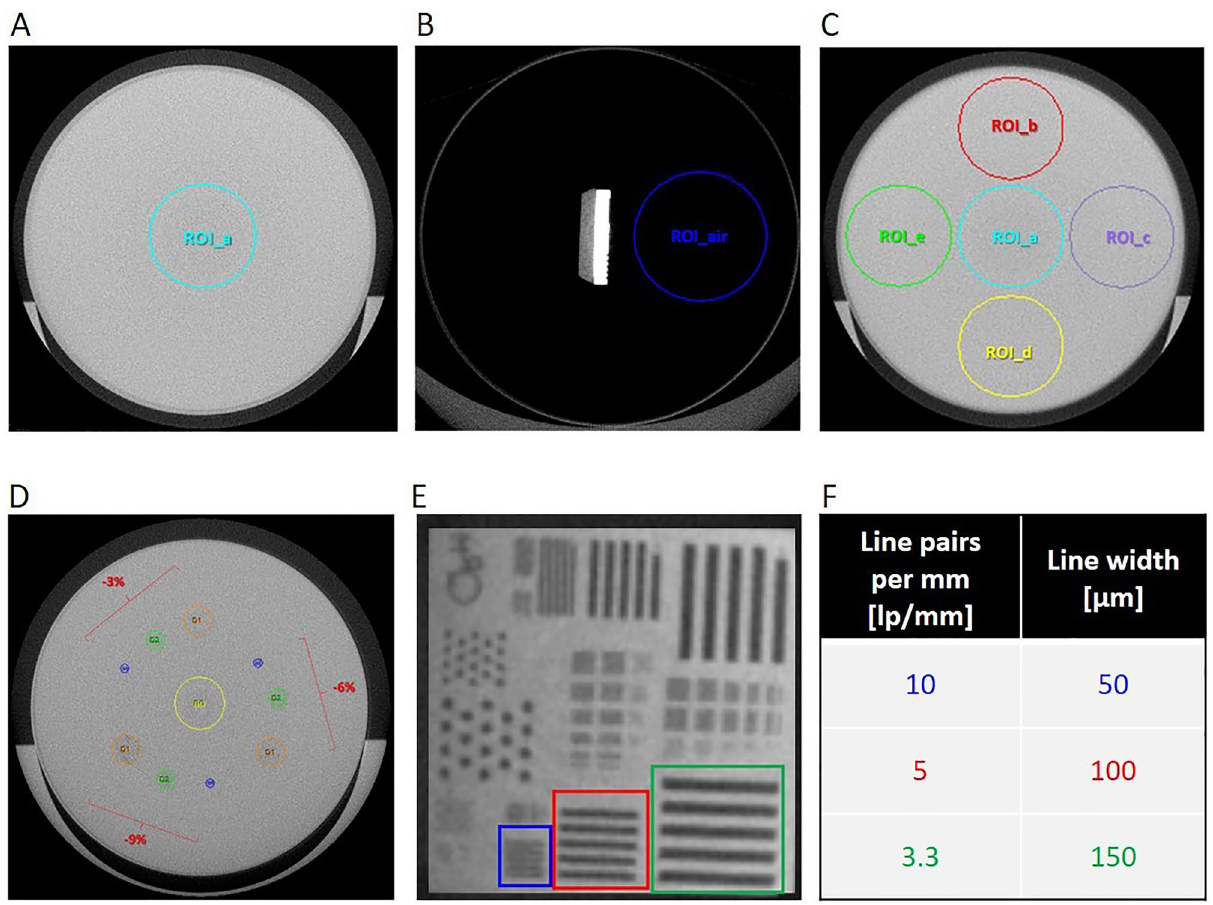
Figure 1. Axial views of micro-CT phantoms and segmentation maps used for the corresponding QC tests. ( A ) Water phantom with the ROI used to perform noise test and water value evaluation, within five contiguous slices. ( B ) Bar Pattern phantom filled with air with the ROI used to monitor air value, within five contiguous slices. ( C ) Water phantom with the ROIs used for the uniformity test, within five contiguous slices: one central (ROI_a) and four peripheral ROIs (ROI_b, ROI_c, ROI_d, ROI_e). ( D ) Low Contrast V2 phantom: the cylindric inserts with different low contrast levels (− 9, − 6 and − 3%) are identified by means of proportional ROIs, orange for 3 mm diameter, green for 2 mm diameter and blue for 1 mm diameter. The central yellow ROI is used to detect the background value. ( E ) The 5 × 5 mm 2 chip of the Bar Pattern phantom: the patterns used for the spatial resolution test are indicated in blue (10 lp/mm), red (5 lp/mm) and green (3.3 lp/mm) and ( F ) the corresponding line widths are